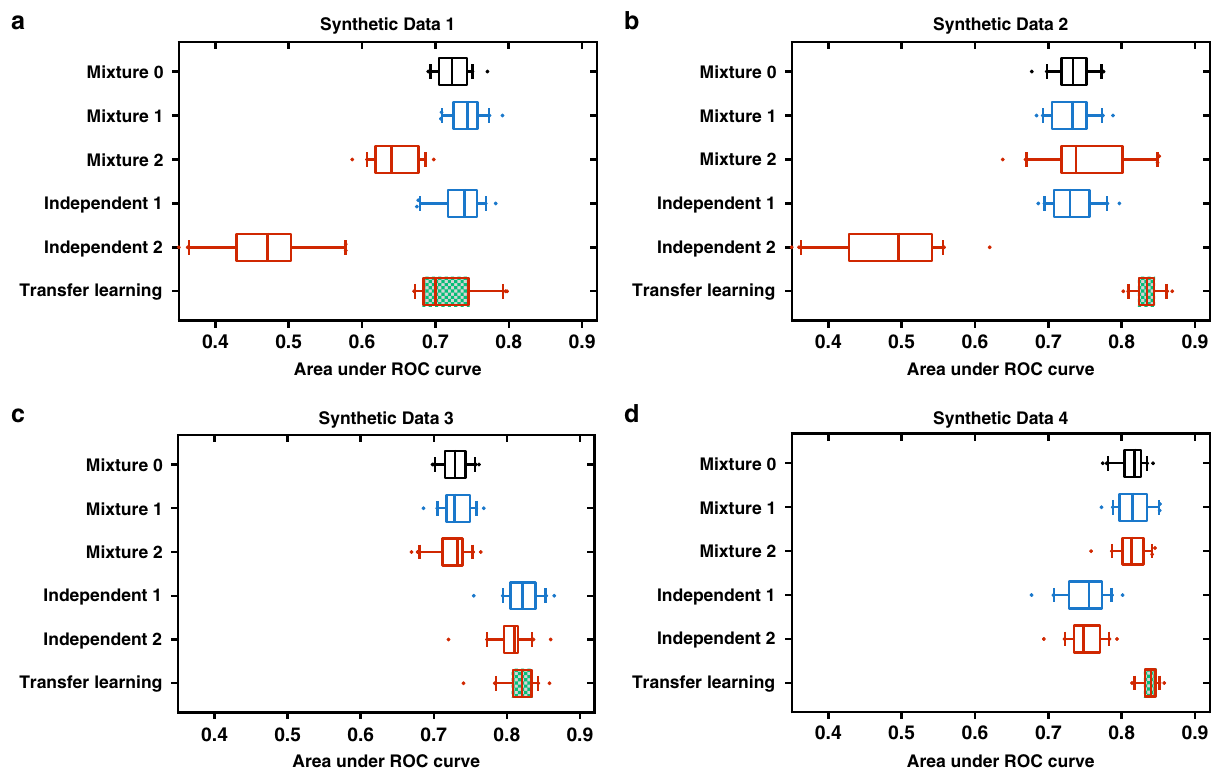
Fig. 4 Comparison of multiethnic machine learning schemes on synthetic data. a Synthetic Data 1, b Synthetic Data 2, c Synthetic Data 3, d Synthetic Data 4. We used threefold cross-validation and performed 20 independent runs for each experiment with different random partitions of training and testing data to assess machine learning model performance. In each panel, box plots show the AUROC values for the six experiments (20 independent runs for each experiment). Box-plot elements are: center line, median; box limits, 25 and 75 percentiles; whiskers, 10 – 90 percentiles; points,